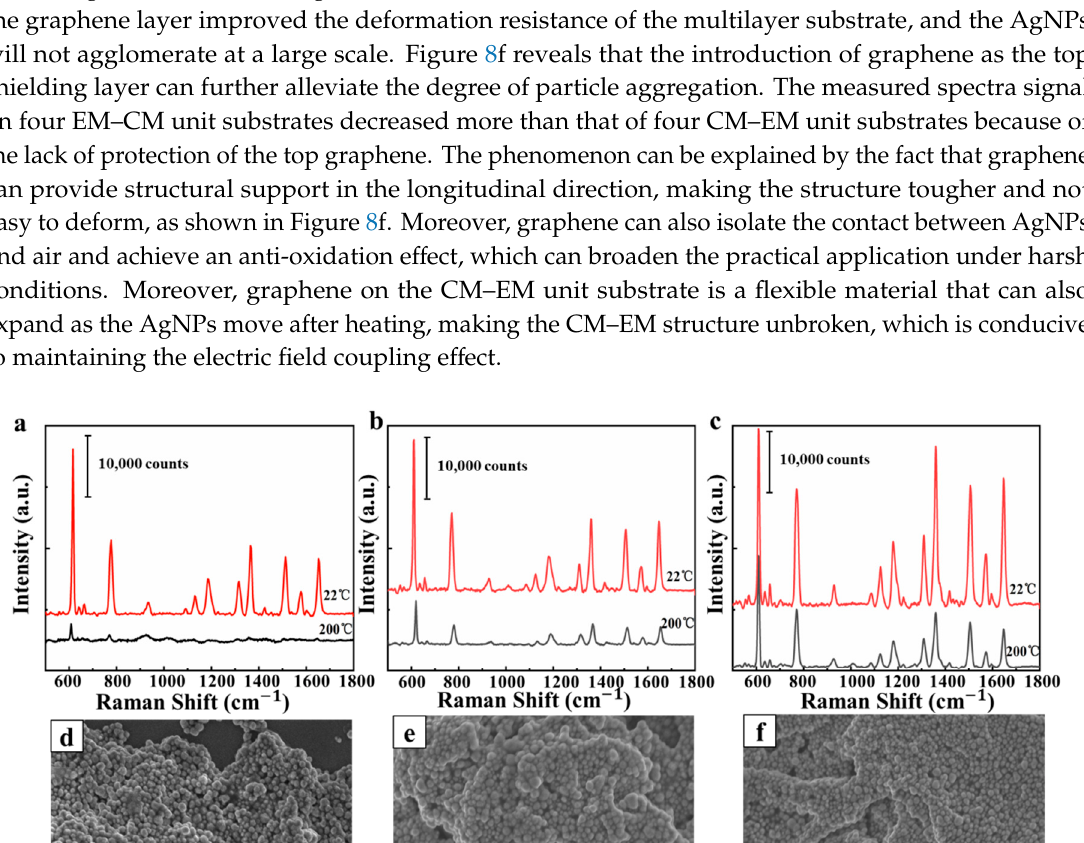
nm wavelength. (b) Electric field enhancement (E/E 0 ) for substrate with different CM–EM units. Figure S2: The